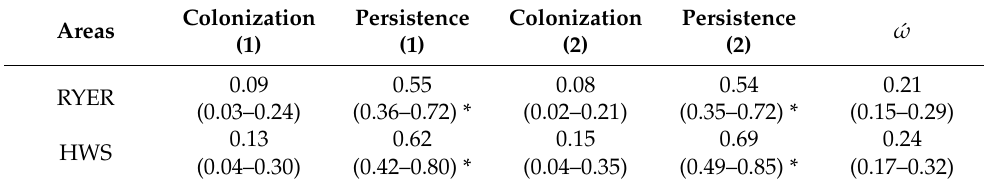
Table 1. Rate of colonization and persistence of the two communities (Rakhine Yoma Elephant Range (RYER) and Htamanthi Wildlife Sanctuary (HWS)) between the first and second years (1) and between the second and third years (2); ´ ω represents the probability that a species of the augmented dataset is part of the community. For all the parameters, median values with 95% Bayesian credible intervals (BCIs) are reported. Asterisks denote that persistence and colonization values were significantly different (no overlap between